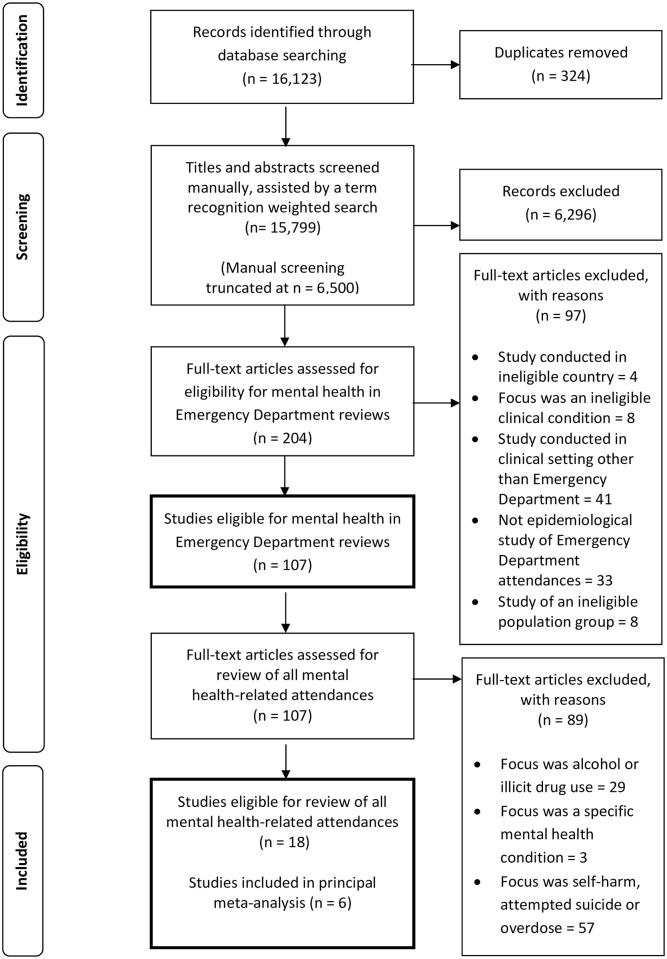
PRISMA Flow Diagram.